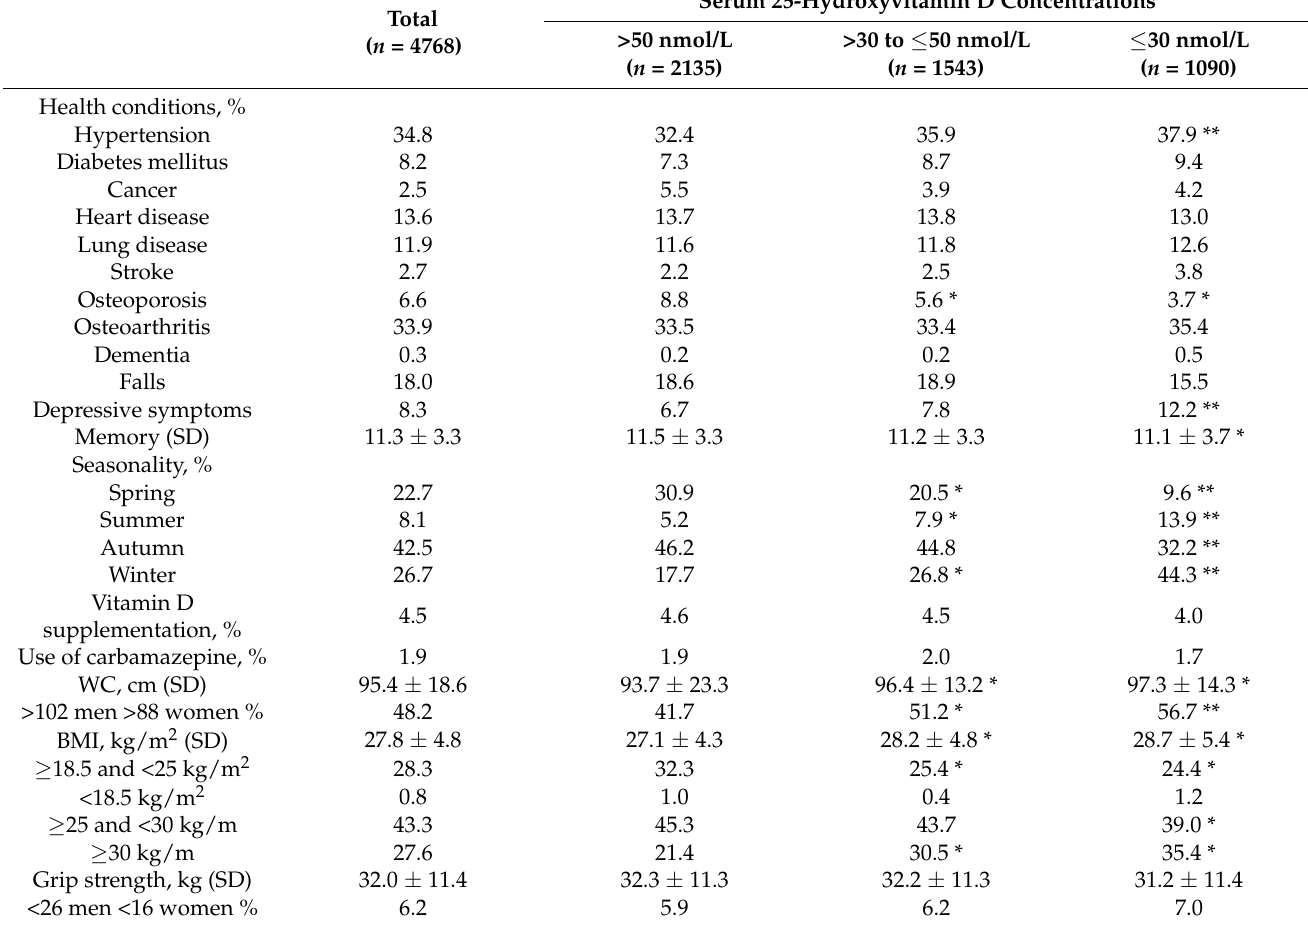
Table 2. Health conditions, anthropometric measures, and covariates of 4768 participants